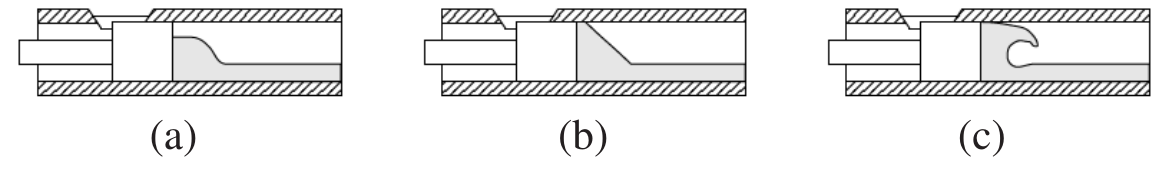
Figure 2. Impact of increasing plunger propagation speed according to [1]. The plunger velocity increases on going from ( a – c